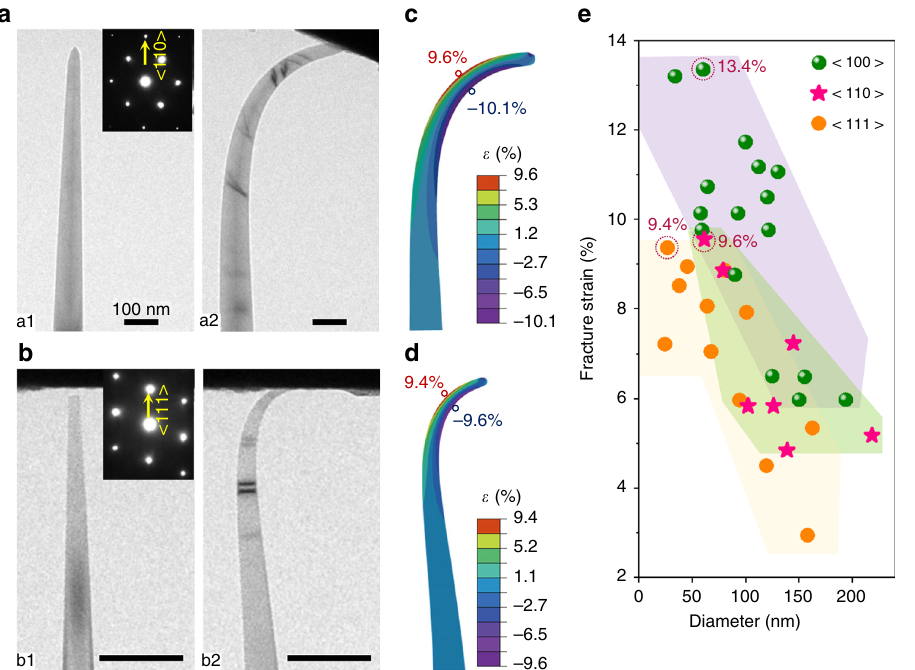
Fig. 4 Orientation- and size-dependent fracture of diamond nanoneedles. a, b TEM images showing the original shape and the maximum deformation immediately before fracture of a <110> ( a ) and a <111> ( b ) nanoneedle. Scalebar is 100 nm. SEAD patterns (insets) indicate orientations in the needles before the tests. c , d FEM simulation reproducing critical geometry of the nanoneedles in a and b , respectively, with maximum principle strain distribution in the nanoneedles. e Relationship between size and fracture strain of the <100>, <110>, and <111>